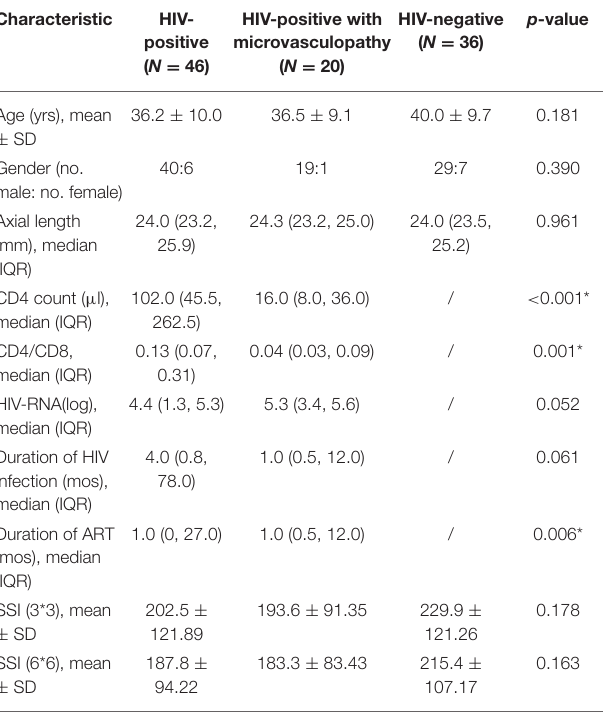
TABLE 1 | Systemic variables and clinical characteristics of participants in this study.